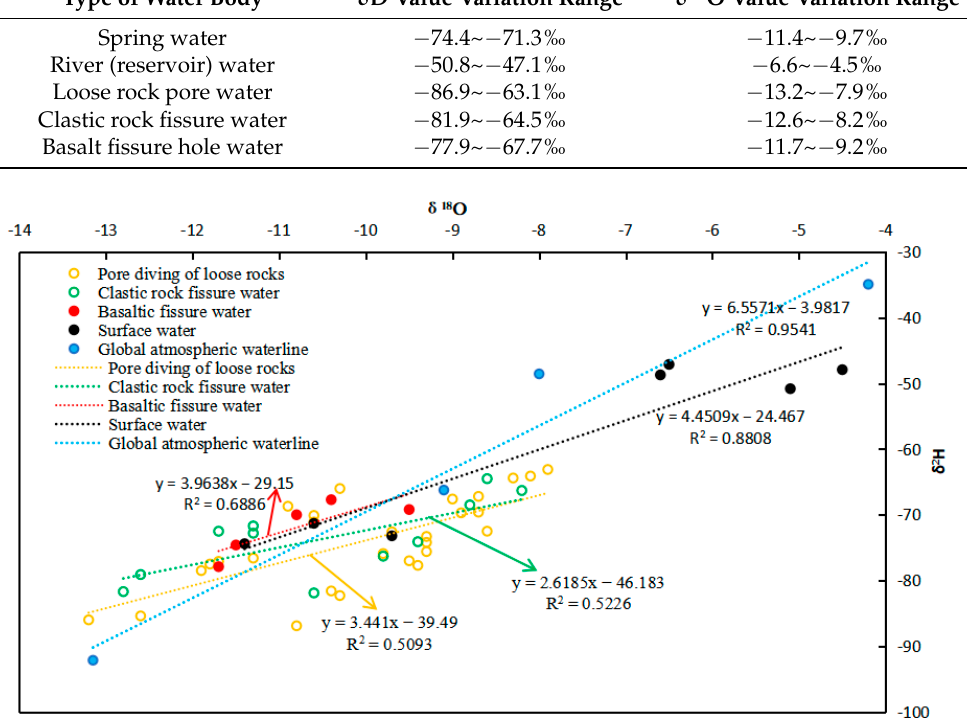
Figure 6. Global meteoric water line (GMWL) and local meteoric water line